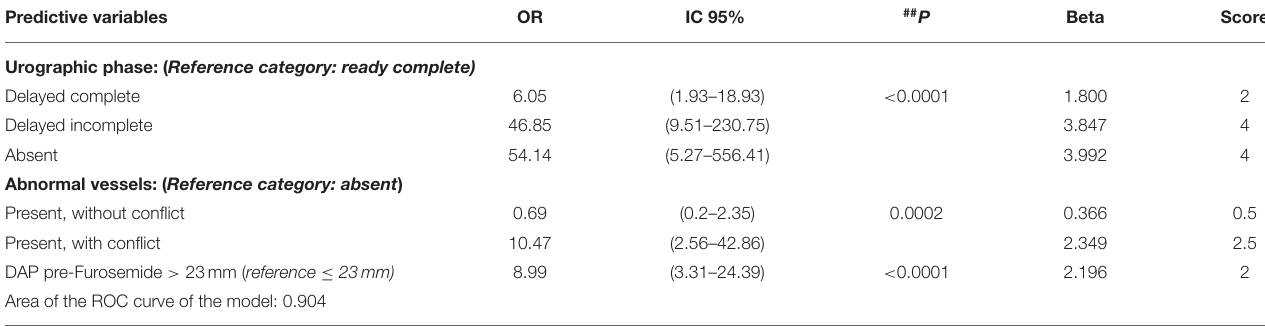
TABLE 3 | Multivariable logistic regression model ( N = 168); outcome variable: surgical intervention: yes (109/168; 64.9%). Predictive